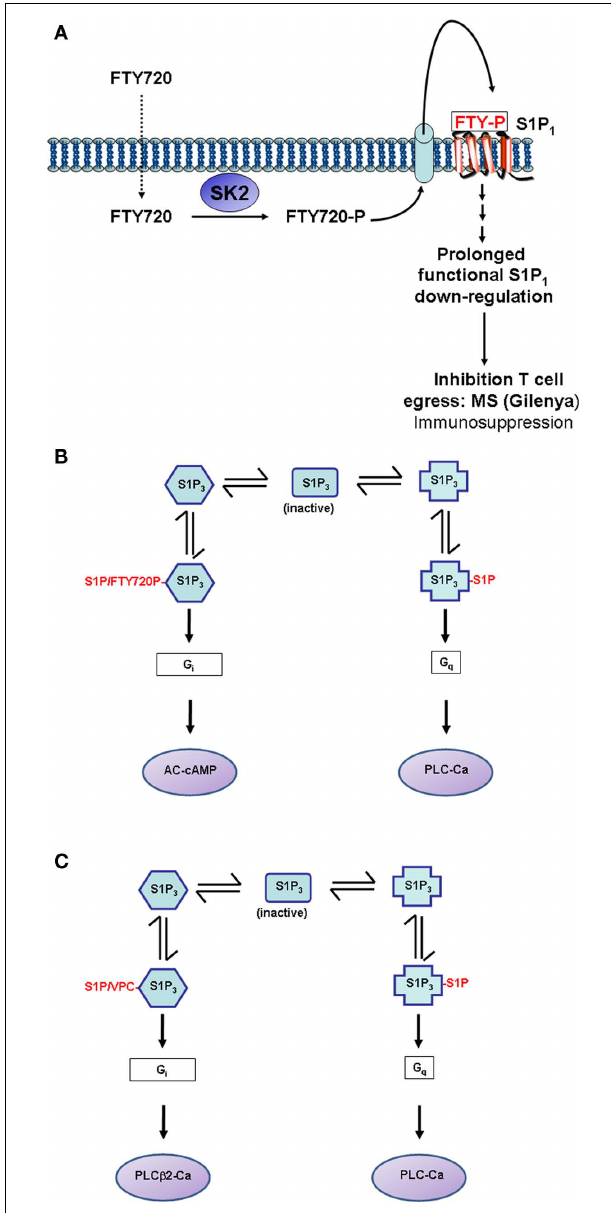
FIGURE 1 | (A) Phosphorylation of FTY720 by sphingosine kinase 2 (SK2) and release to induce down-regulation of S1P 1 . (B) and (C) Equilibrium transition model showing the binding of S1P, FTY720 phosphate (FTY720P), orVPC23019 (VPC) to the conformational states (denoted by different shapes) of S1P 3 coupled to different G-proteins.The positions of the equilibrium in (B,C) will be affected by binding of S1P, FTY720P, or VPC23019 to the different conformations of S1P 3 but are not represented here for simplicity.The ligands are shown in